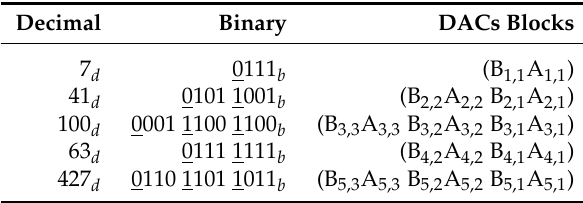
Table 6. Example of an integer sequence and the corresponding DACs blocks of the integers. Decimal Binary DACs Blocks